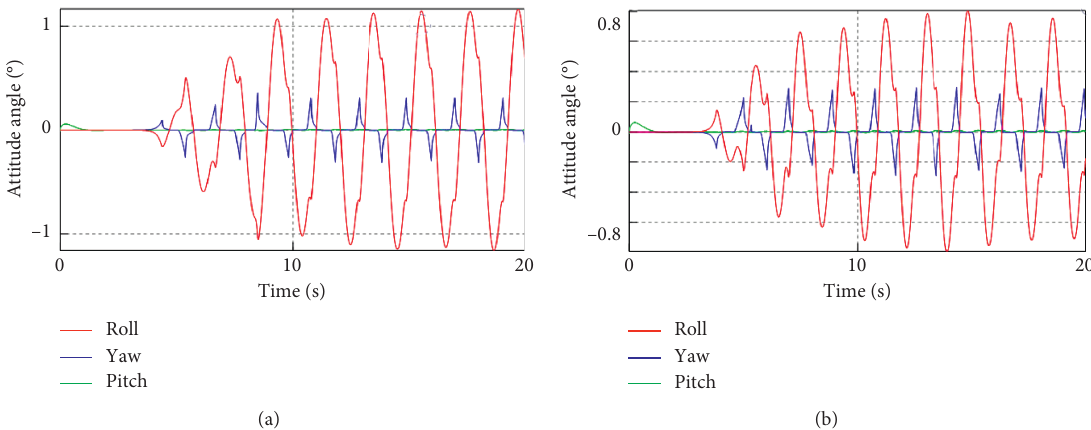
Figure 9: Change in the attitude angle of the single-bogie vehicle under different driving wheel treads. (a) 374mm. (b) 574